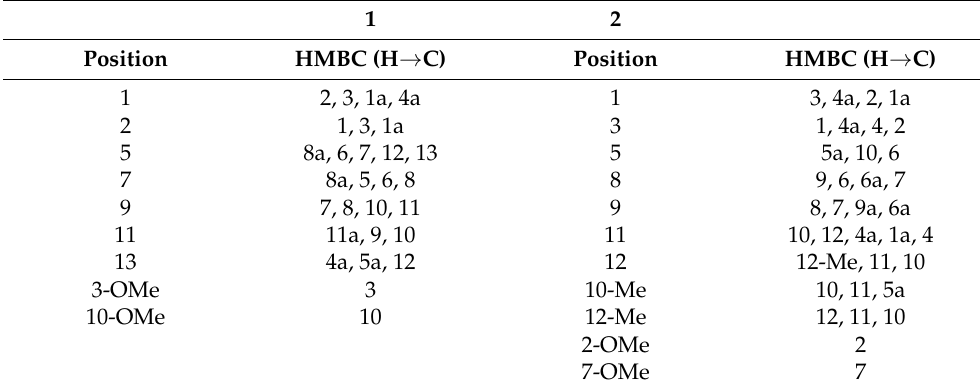
Table 3. Major HMBC correlations for compounds 1 and 2